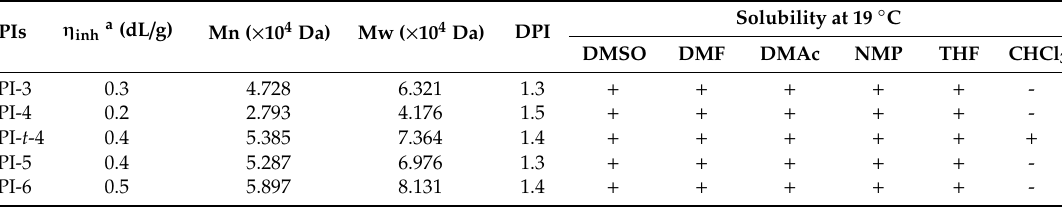
Table 1. Inherent viscosity, molecular weight, and solubility.